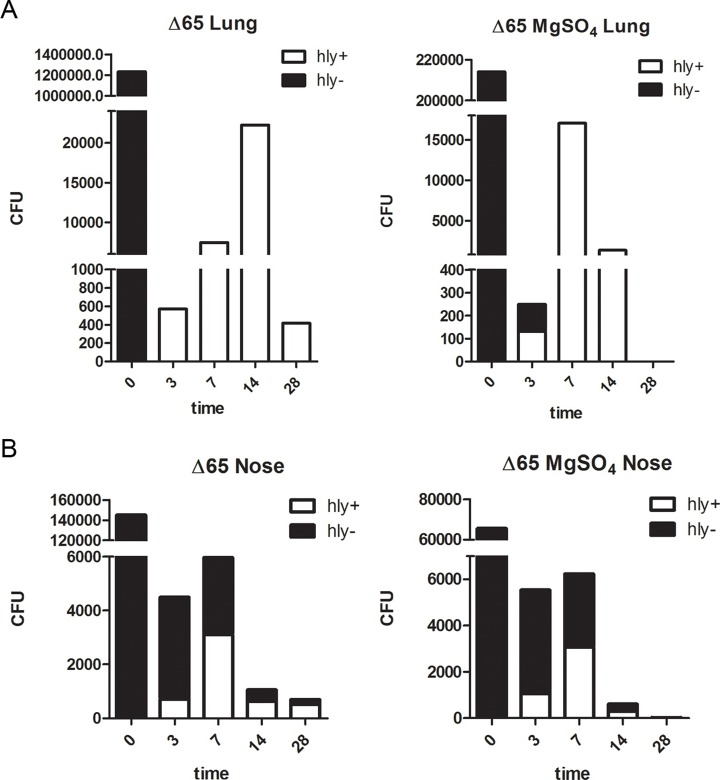
Time course of the appearance of hemolytic colonies in the noses and lungs of mice infected with BP-BvgSΔ65.A and B. Aggregate numbers of hemolytic colonies (hly+) in the samples recovered from the lungs (A) and the noses (B), at the indicated time points in days post-inoculation.